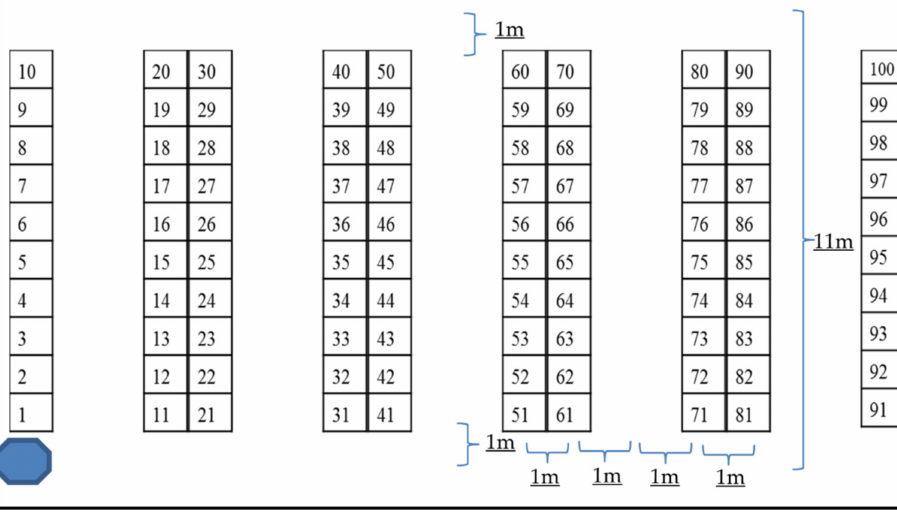
Figure 2. Conventional Warehouse